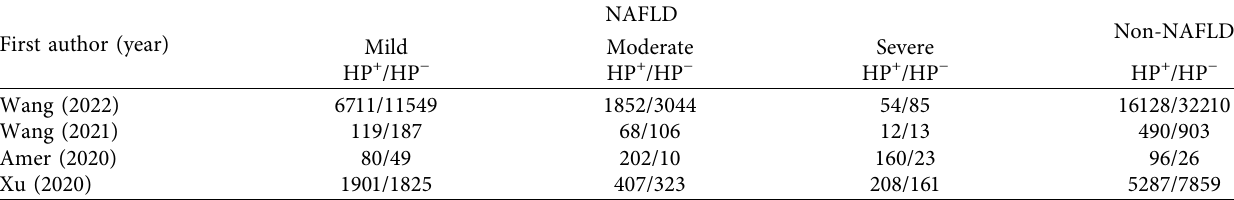
Table 4: H. pylori infection and NAFLD